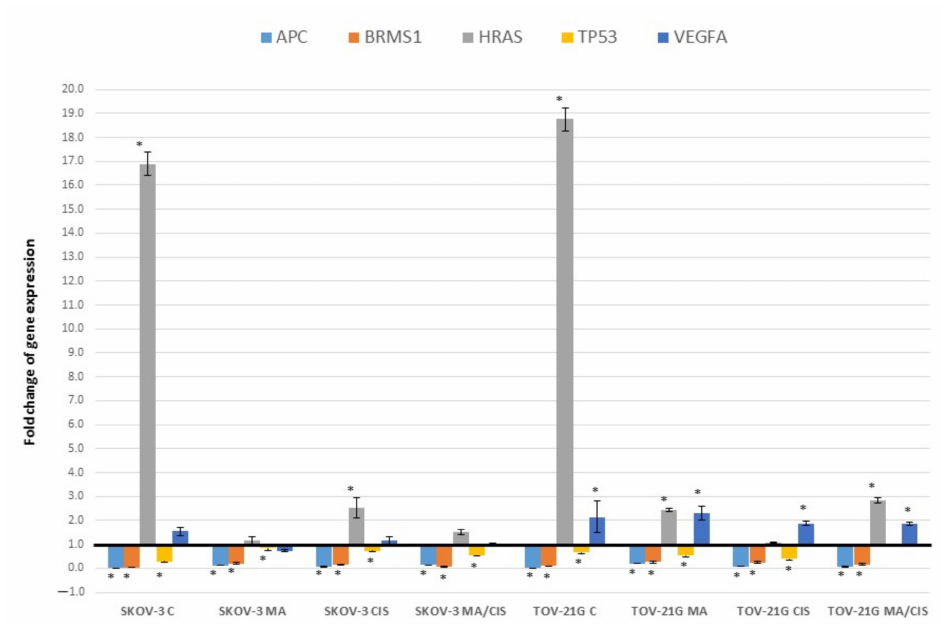
Figure 3. Effect of exosomes derived from SKOV-3 and TOV-21G cells (untreated with drugs, α - mangostin and/or cisplatin-treated) on the expression of cell cycle markers in fibroblasts. The data are shown as mean ± SD of triplicate experiments, statistically significant results * ( p <